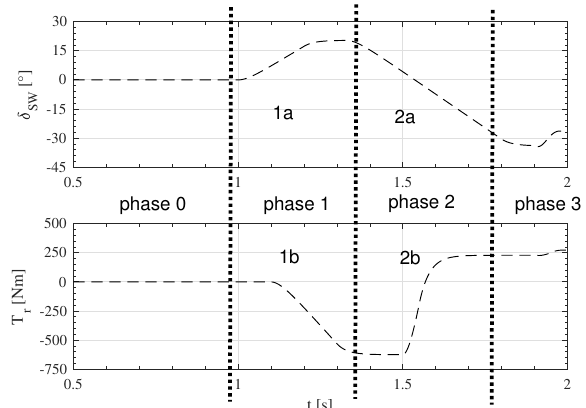
Figure 6. Open-loop sequence for starting the drift maneuver. Steering wheel δ SW and driver required driving/braking torque T r